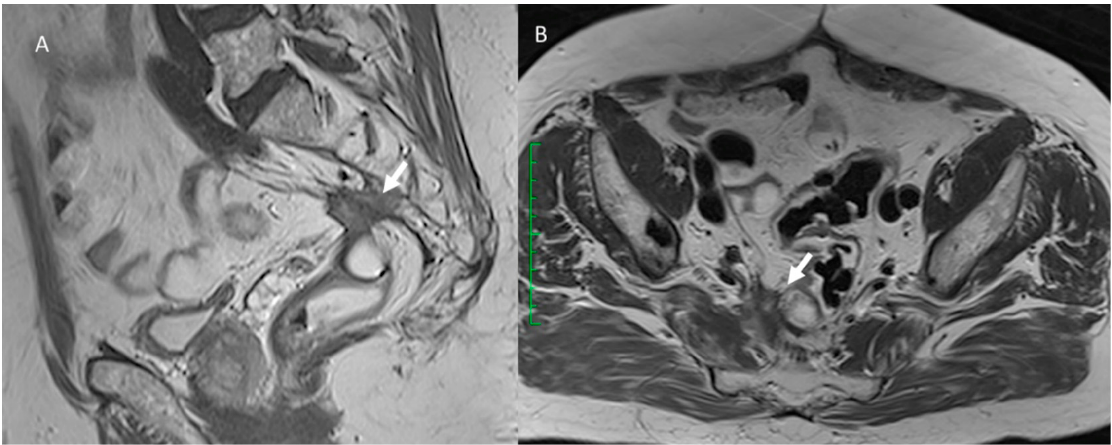
Figure 3. MRI assessment of rectal cancer relapse. In ( A ) (T2-W in axial plane) and ( B ) (T2-W in sagittal plane), arrows show relapse that involves rectal wall and external planes.